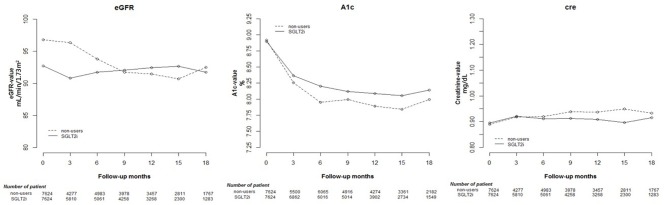
Change in estimated glomerular filtration rate (eGFR), and glycated hemoglobin (HbA1c), and creatinine (Cre) levels in users of sodium–glucose cotransporter 2 (SGLT2) inhibitors and other drugs.